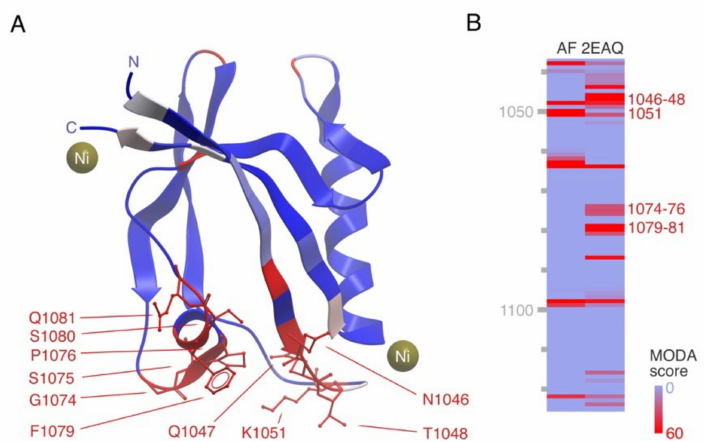
Figure 4. Structure of PDZ domain of LMO7 and its membrane binding site. ( A ) The crystal structure of the LMO7 PDZ domain (PDB: 2EAQ) is shown with the residues showing significant phospholipid bilayer binding propensities indicated in red, along with sidechains for those forming the major membrane binding surface. The N- and C- termini and two nickel ions bound in the crystal structure are also depicted. ( B ) The heatmap shows the residues with significant membrane binding propensities in the AlphaFold and crystal structures in red, as calculated by MODA, with the remainder in blue, based on the inset